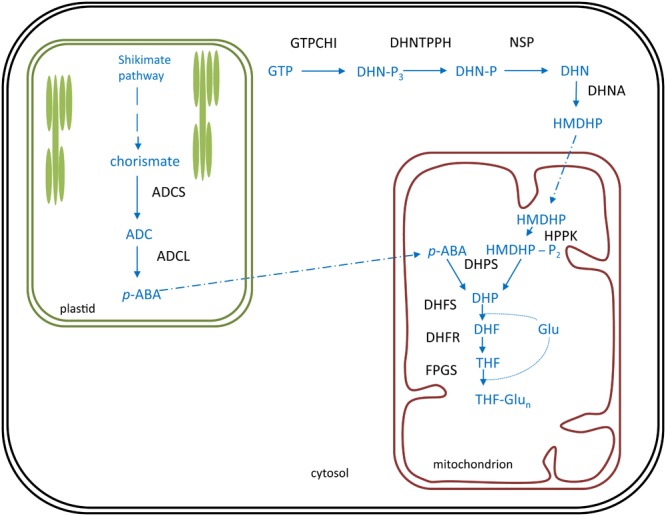
Folate biosynthesis is plants. Folate (vitamin B9) biosynthesis in plants occurs in three subcellular compartments: the cytosol, the plastids (green) and the mitochondrion (red). Biosynthesis pathway is shown in blue, enzymes in black. Polyglutamylated folates are considered the end product of folate biosynthesis. Products: ADC, aminodeoxychorismate; p-ABA, para-aminobenzoate; DHN-P3, dihydroneopterin triphosphate; DHN-P, dihydroneopterin monophosphate; DHN, dihydroneopterin; HMDHP, 6-hydroxymethyldihydropterin; HMDHP-P2, HMDHP pyrophosphate; DHP, dihydropteroate; DHF, dihydrofolate; Glu, glutamate; THF, tetrahydrofolate. Enzymes: ADCS, ADC synthase; ADCL, ADC lyase; GTPCHI, GTP cyclohydrolase I; DHNTPPH, dihydroneopterin triphosphate pyrophophohydrolase; NSP, non-specific phosphatase; DHNA, DHN aldolase; HPPK, HMDHP pyrophosphokinase; DHPS, DHP synthase; DHFS, DHF synthetase; DHFR, DHF reductase; FPGS, folylpolyglutamate synthetase.